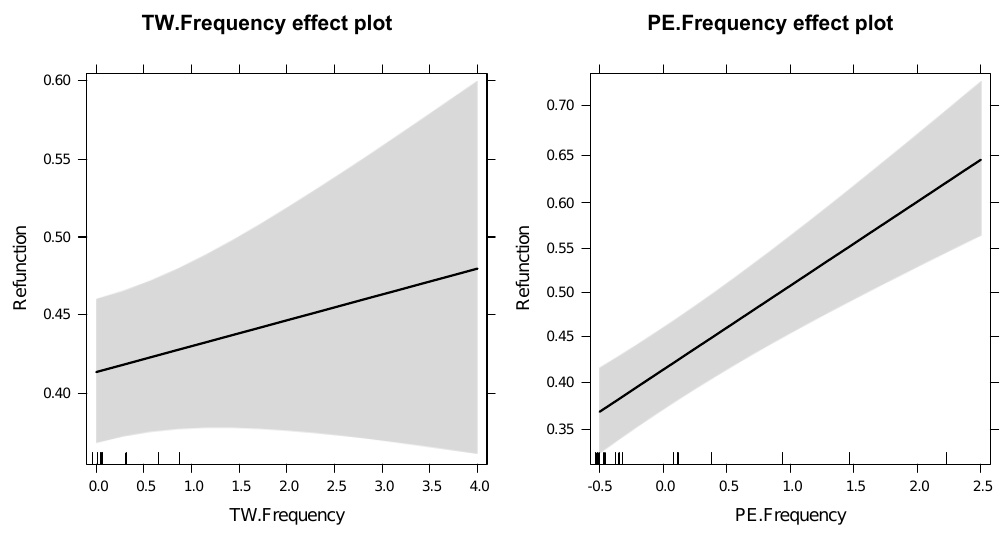
Figure 5. Effect plot for TW.F REQUENCY and PE.F REQUENCY .